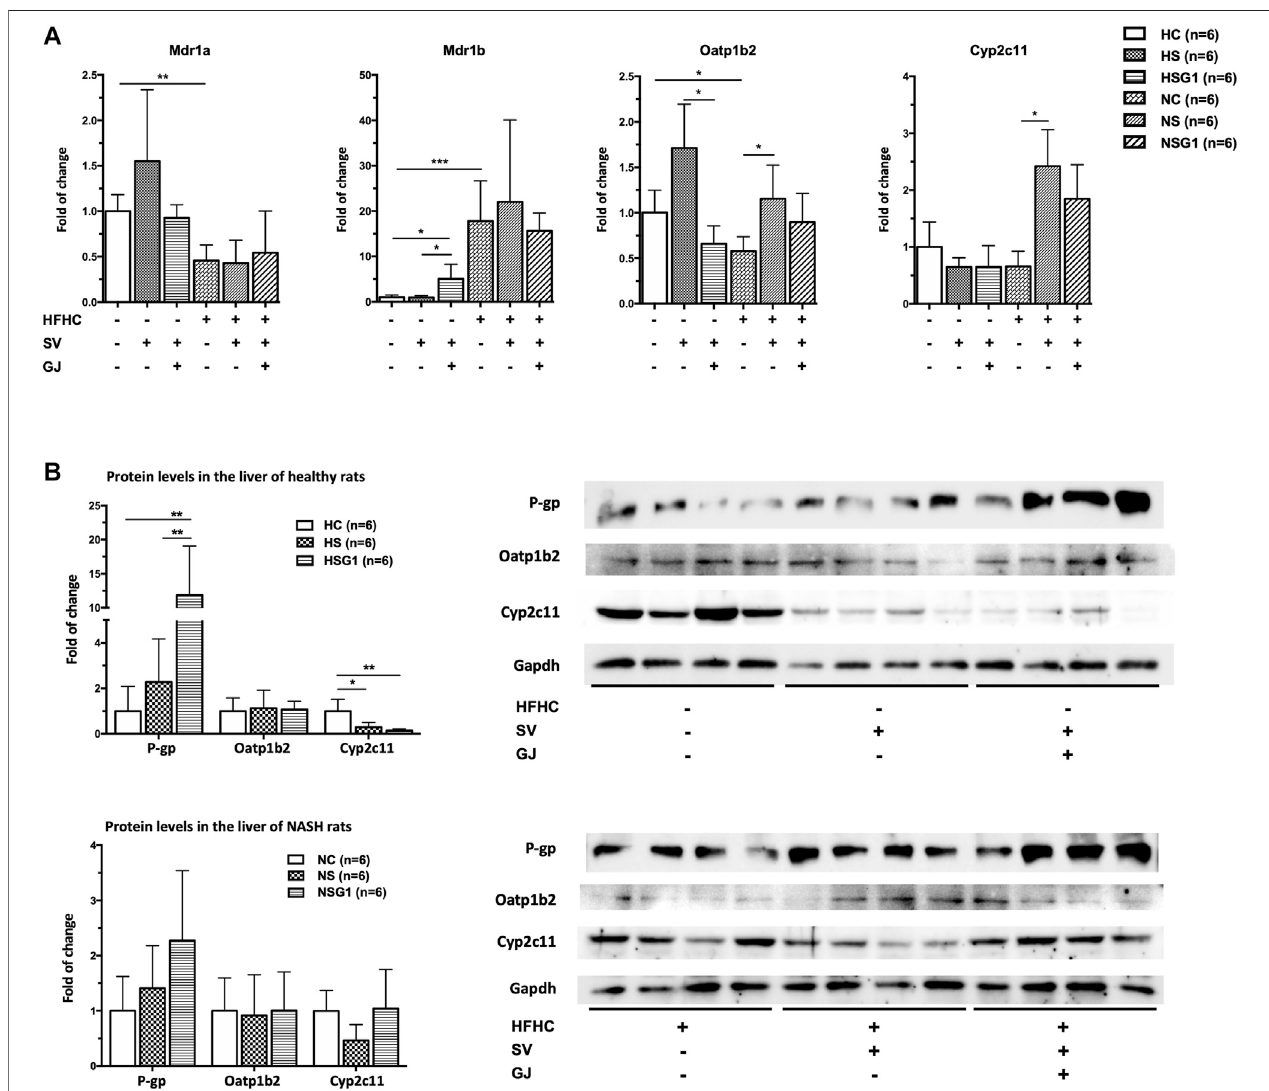
FIGURE 4 | Hepatic mRNA (A) and protein (B) levels of Mdr1a/1 b (P-gp), Oatp1b2, and Cyp2c11 in healthy and NASH rats which received vehicle (HC and NC), SV (HS and NS), and SV and GJ (HSG1 and NSG1) with representative bands. H and N denoted healthy and NASH, respectively. C, S, and G indicated that the rats received vehicle, SV, and GJ, respectively. * p < 0.05, ** p < 0.01, and *** p < 0.001.